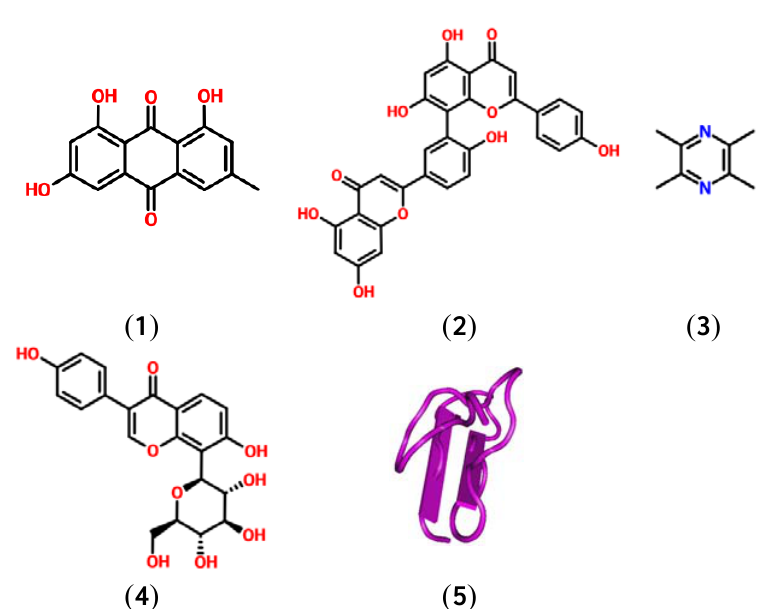
Figure 1. Molecules from natural products with analgesic activity through P2XR antagonism [18]: ( 1 ) Emodin; ( 2 ) Amentoflavone; ( 3 ) Ligunstrazine; ( 4 ) Puerarin and ( 5 ) Purotoxin-1 (PDB: